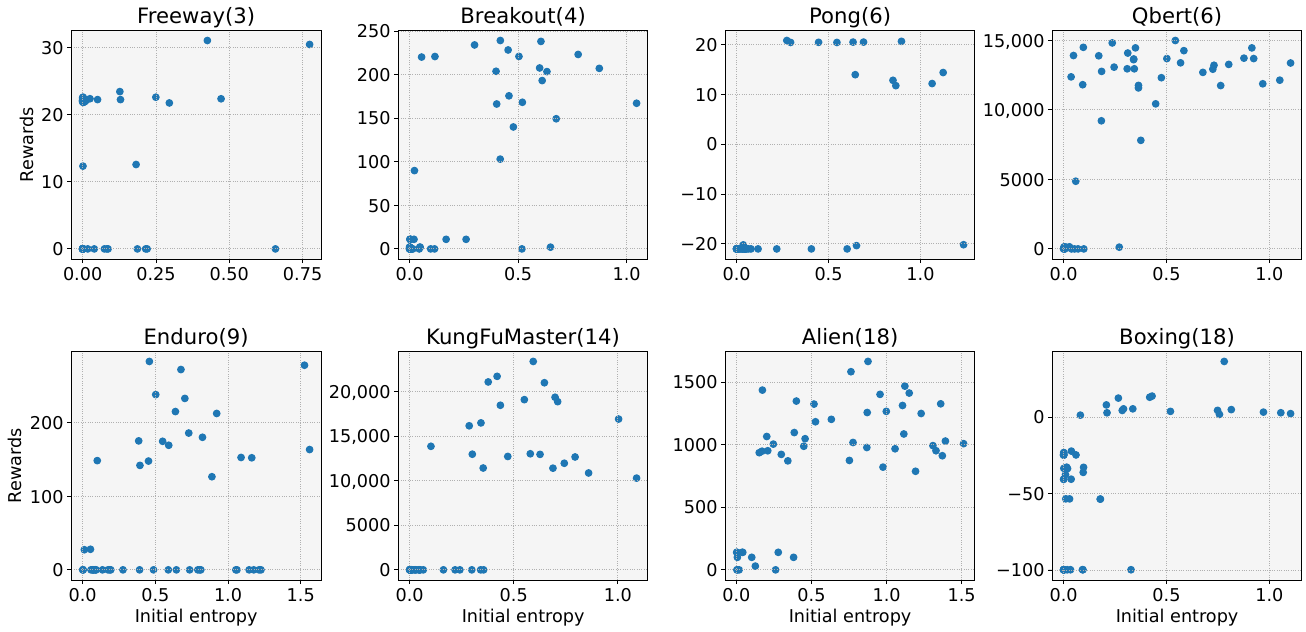
Figure 2. Reward depending on the initial entropy for 8 tasks, where 50 models for each task were generated to investigate the effect of the initial entropy on the